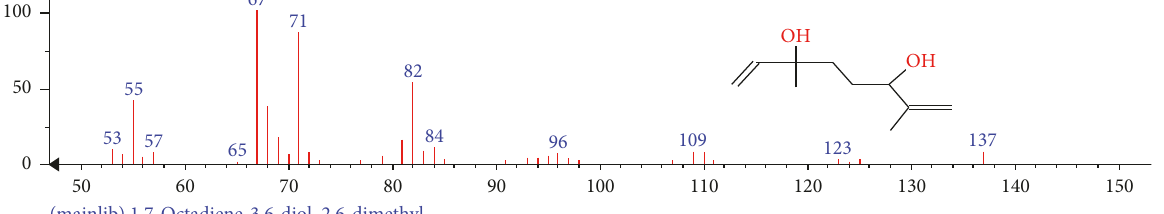
Figure 17: Mass spectrum of compound 1,7-octadiene-3,6-diol, 2,6-dimethyl of whole plant hexane fraction of Achillea wilhelmsii (WHFAW).